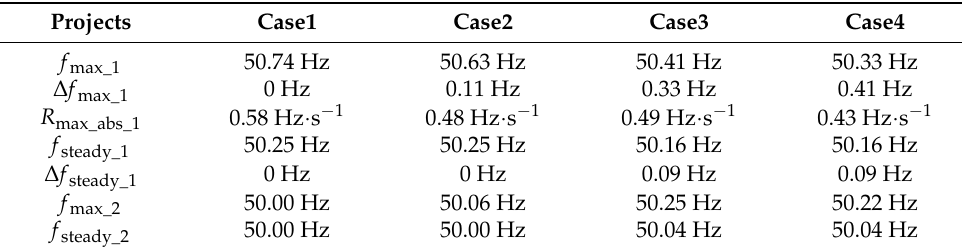
Table 3. Results under different frequency control modes (sudden decrease in load).